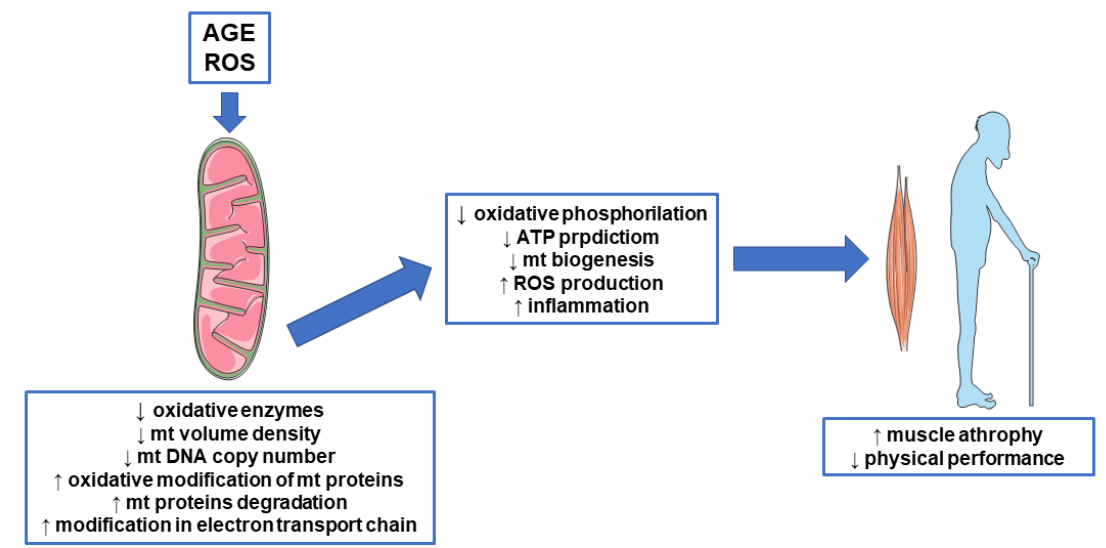
Figure 4. Advanced glycation end products (AGE), mitochondrial disfunction, and sarcopenia. AGE and reactive oxygen species (ROS) can affect mitochondrial function by decreasing oxidative enzymes and inducing oxidative alteration of mitochondrial proteins, which result in protein degradation and loss of function as well as lower mitochondrial (mt) volume density and mitochondrial DNA (mtDNA) copy number, a marker of mitochondrial biogenesis/mass. These mechanisms lead to reduced mitochondrial function, which in turn could induce a state of muscle atrophy.